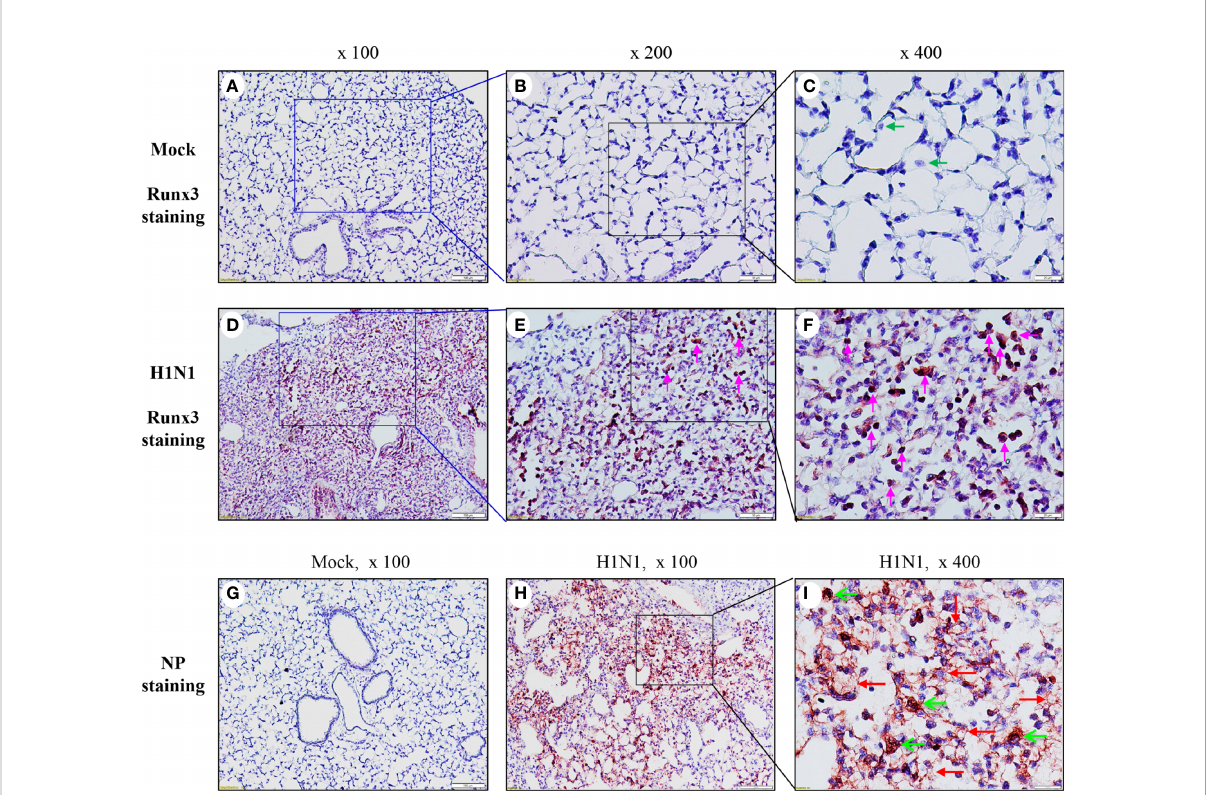
with a Runx3 monoclonal antibody by using Vector M.O.M immunodetection kit (n=6 each group). Positive immunoreactivities (red) were mainly detected in immune cells of IAV-infected mouse lungs ( D – F, pink arrows). The regions indicated in (A, D) (magni fi cation, x100) are shown at higher magni fi cation in (B, E) (x200) and in (C, F) (x400). (G – I) Immunohistochemistry analysis of IAV NP in mock control and IAV-infected mouse lungs. Lung sections from saline-treated (Mock, G ) or H1N1-infected mice on day 7 pi (H, I) were subjected to immunostaining with a speci fi c NP polyclonal antibody (n=3/group). Positive immunoreactivities (red) were detected in epithelial (red arrows) and immune cells (green arrows) of IAV-infected mouse lungs (H, I)